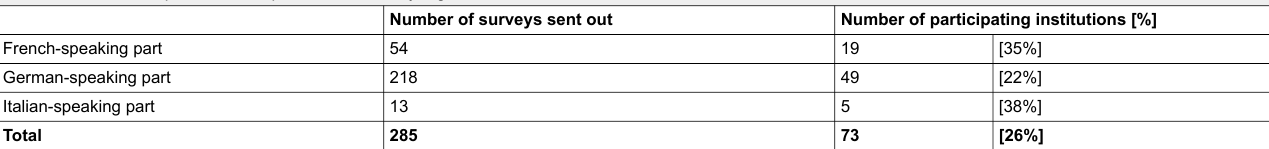
Table 2: Rate of acceptance for hospitals and clinics by regions of Switzerland . Number of surveys sent